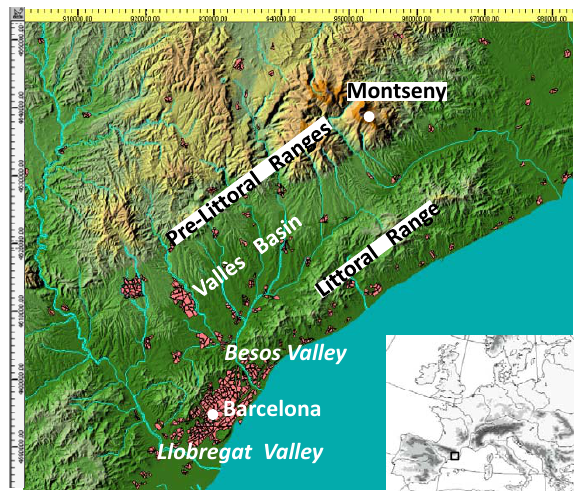
Fig. 1. Location map of both monitoring sites, Barcelona and Montseny; indicating the main topographic features that influence the air pollutant concentrations and transport. The major coastal city of Barcelona is confined between the Mediterranean Sea and the Littoral Range. The urban pollution plume commonly moves from the coast into the Vall`es Basin, contaminating the hinterland of the Pre-Littoral Ranges where the remote Montseny monitoring site is